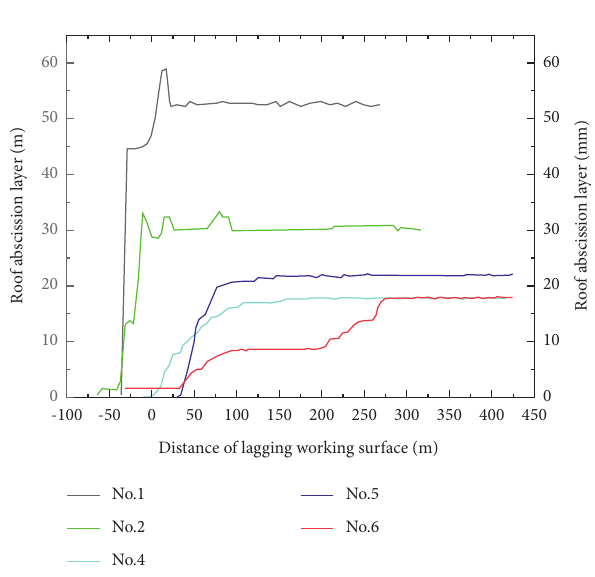
Figure 8: Variation curve of roof